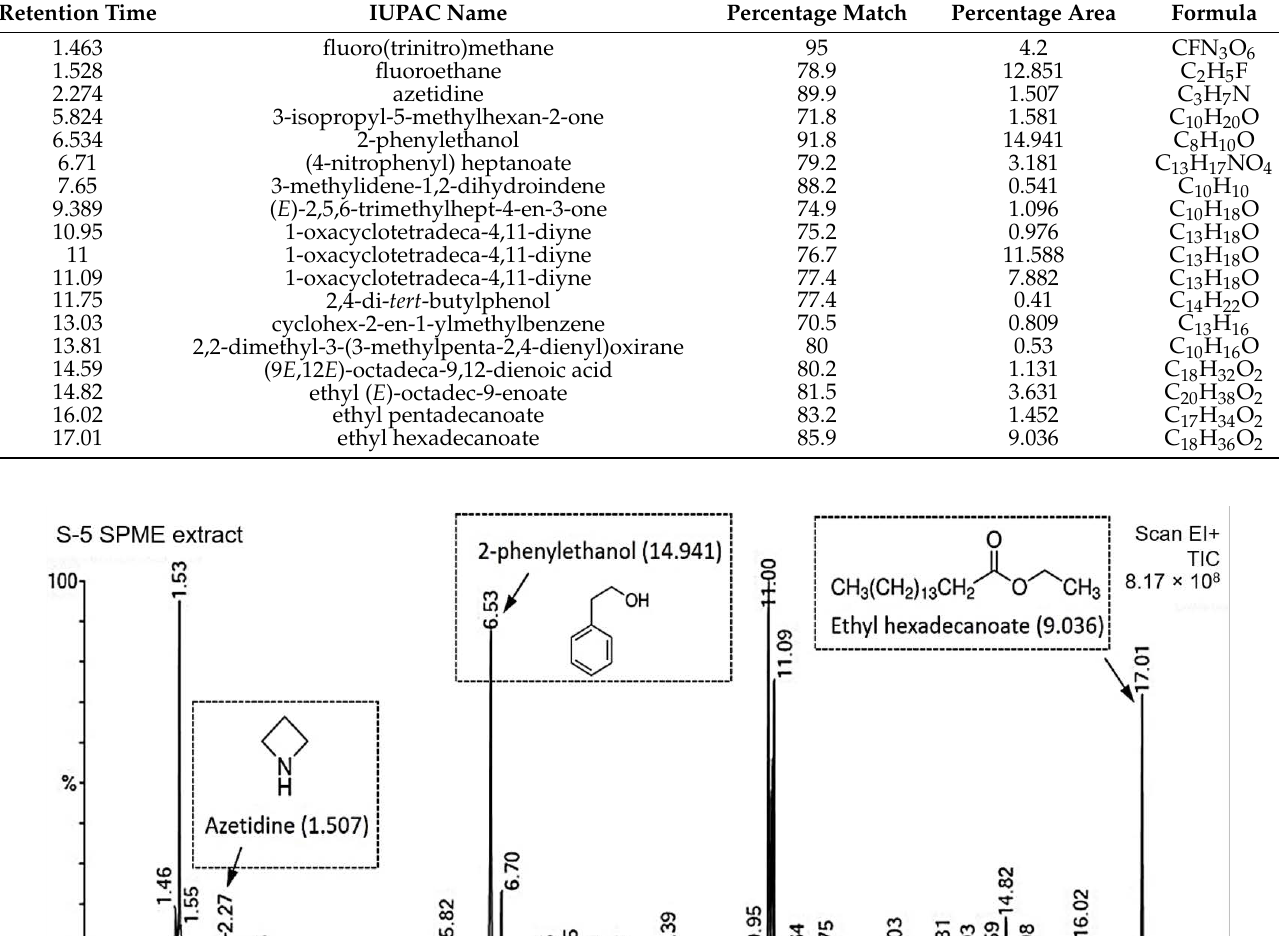
Table 1. International Union of Pure and Applied Chemistry (IUPAC) names of volatile compounds produced by T. konin-